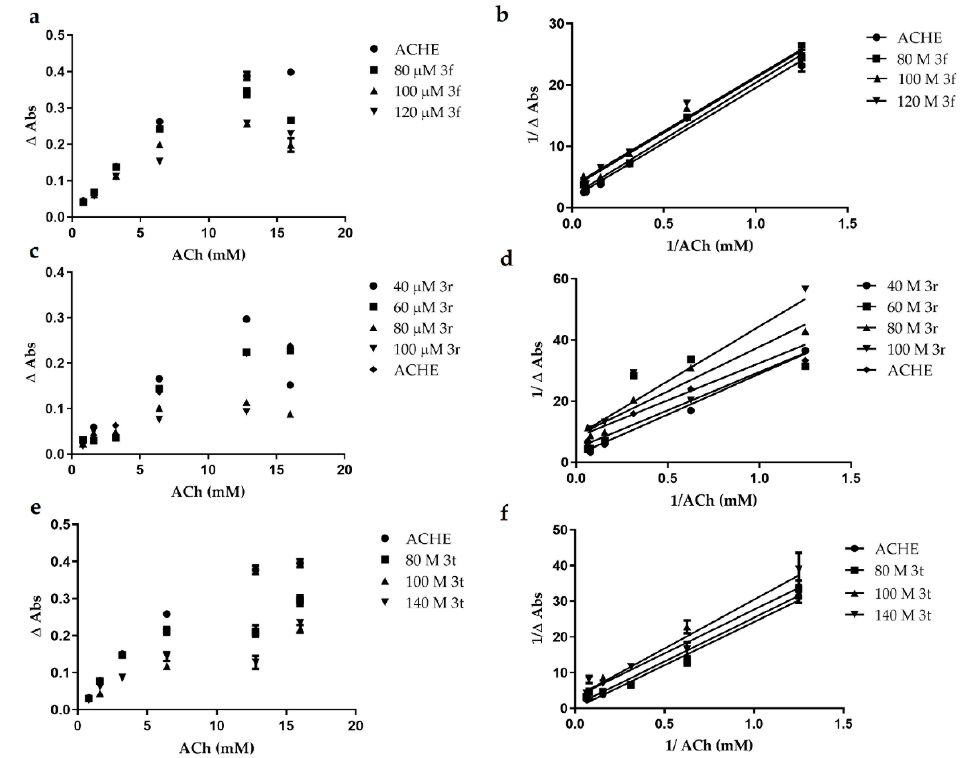
Figure 5. Enzymatic kinetic of AChE in presence of 3f , 3r and 3t . Michaelis and Menten kinetic of compound ( a ) 3f; ( c ) 3 r and ( e ) 3t ; The Lineweaver Burk method for ( b ) 3f ; ( d ) 3r and ( f ) 3t .